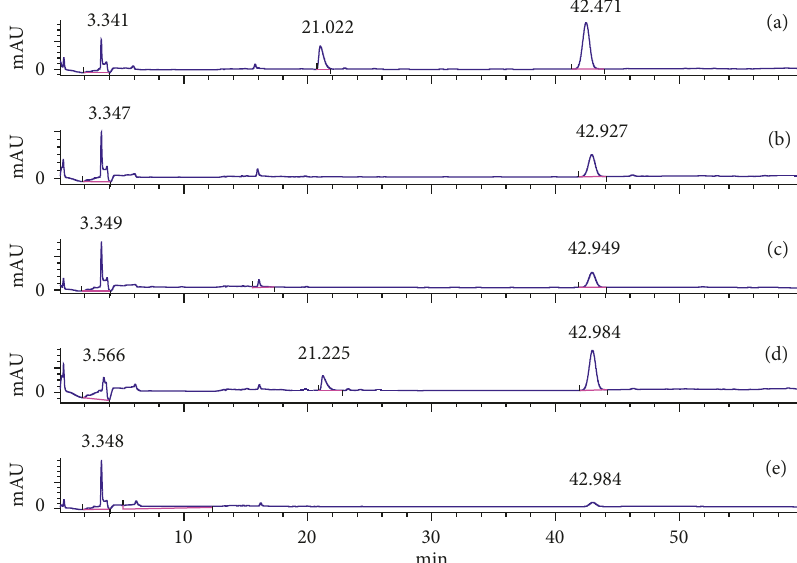
Figure 5: Chromatograms of sugar derivatives: (a) glucose, (b) fructose, (c) sucrose, (d) mixture, and (e) ABEE.